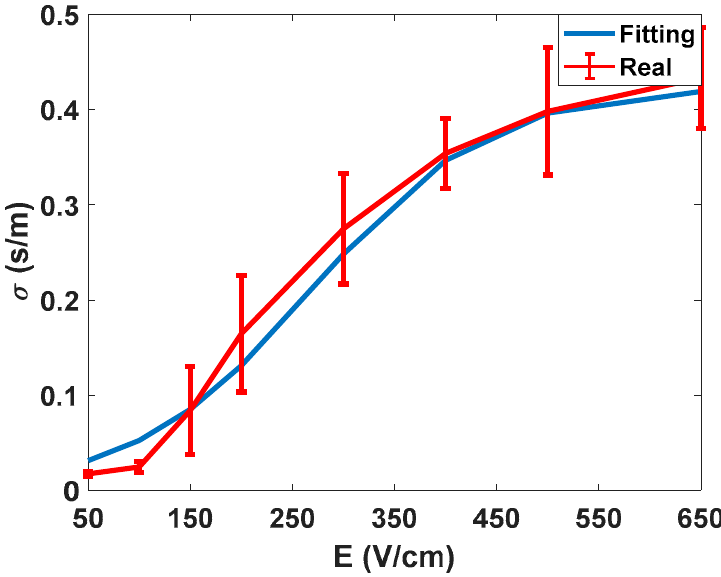
Figure 7. Electrical conductivity of potato tissue as a function of the applied electric field at 10 kHz.